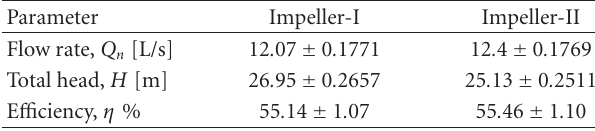
Table 2: Best e ffi ciency conditions with uncertainty